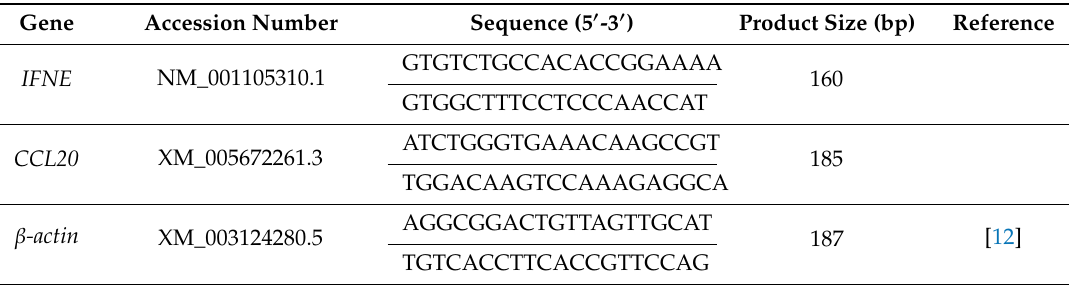
Table 1. Primers used for real-time quantitative PCR analysis